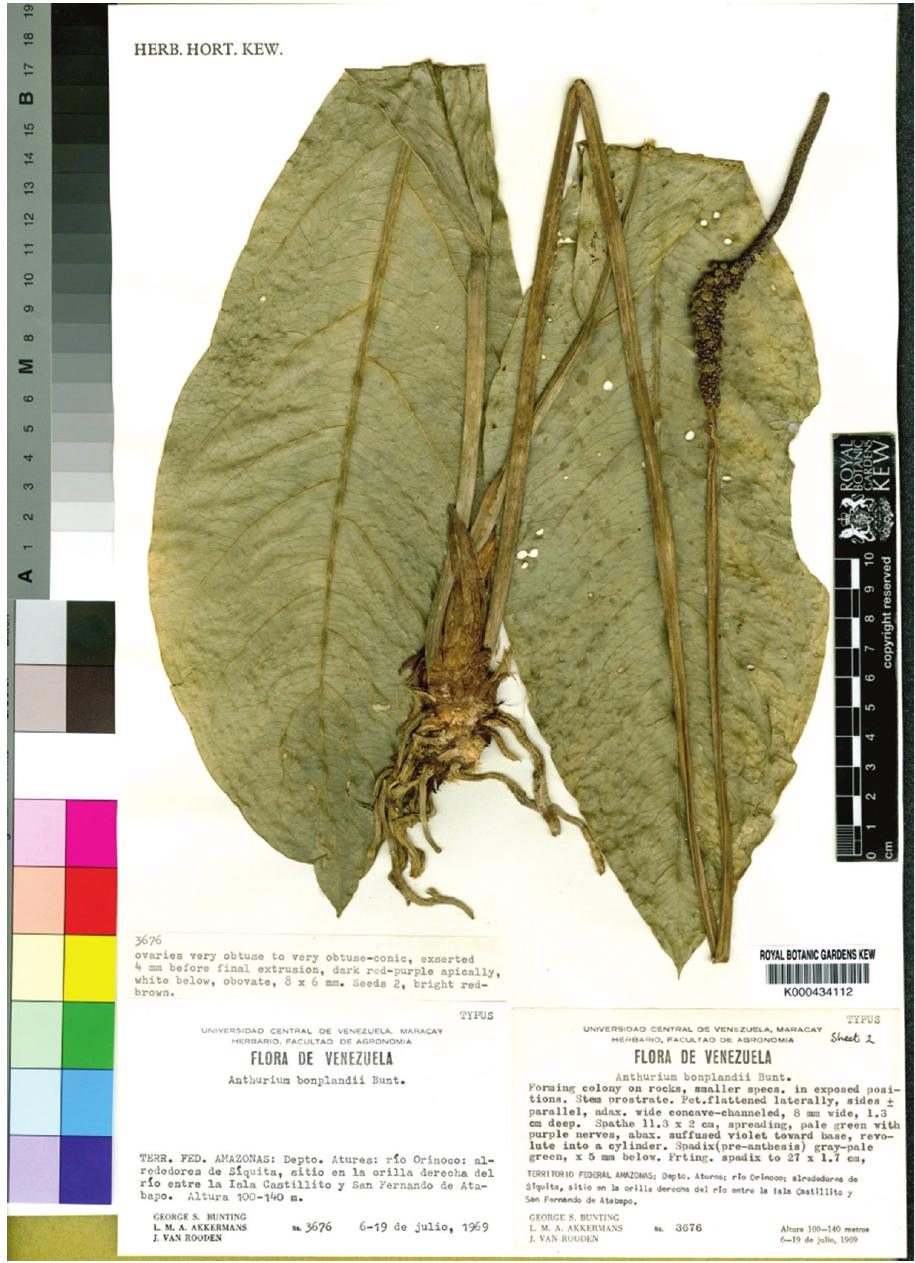
Figure 2. Lectotype of Anthurium bonplandii subsp. bonplandii in K herbarium (K000434112). We cannot be sure if one of them is the original holotype designated by Bunting, but it is clear from their original labels that they are isotypes, according to ICN (Art. 9.5). Since the holotype has not been found, we have designated G.S. Bunting , L.